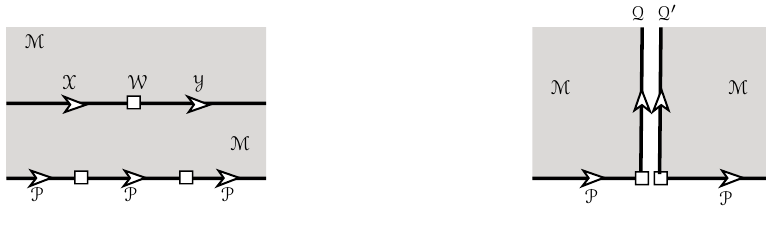
Figure 3 . These pictures illustrate the physical meaning of the proof of Theorem ph